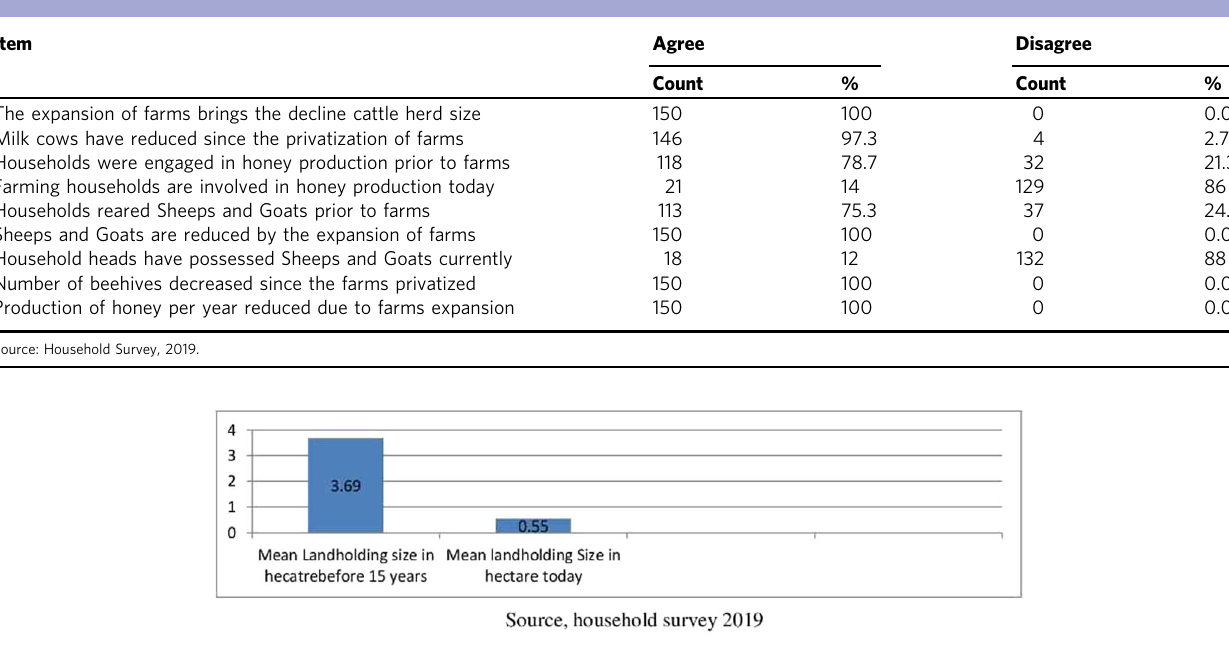
Fig. 4 Comparison of current mean Cattle, Bee Hive, and Sheep and Goat assets of households before 15 years. Figure makes a comparison of the current mean Cattle, Bee Hive, Sheep and Goat assets owned by surveyed households before the last 10 years. It tried to show the in fl uence of farms on the livelihoods of fl anking communities. Table 3 The perception of respondents about the effect of farms on government-society relations. Items Agree count % % State-society relations has been affected by Birr and Ayehu